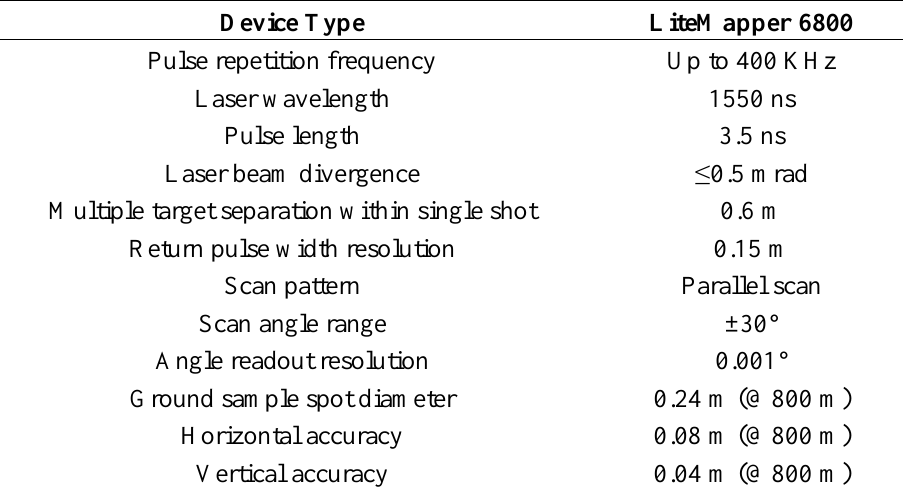
Table 1. Main technical parameters of LiteMapper